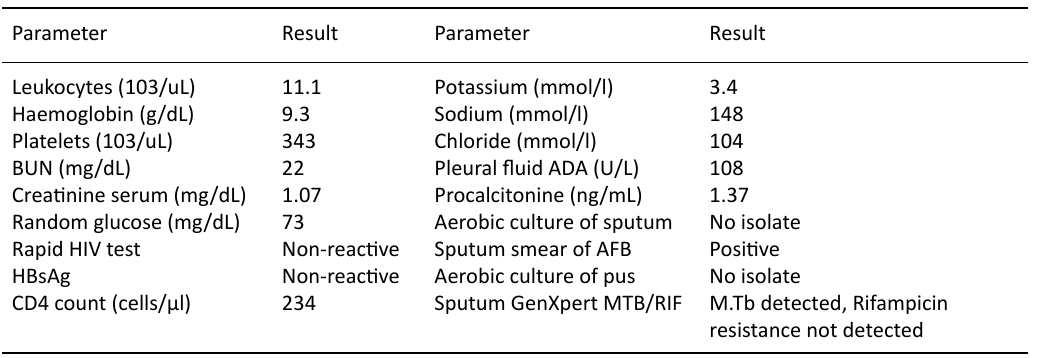
table 1. Patient examination